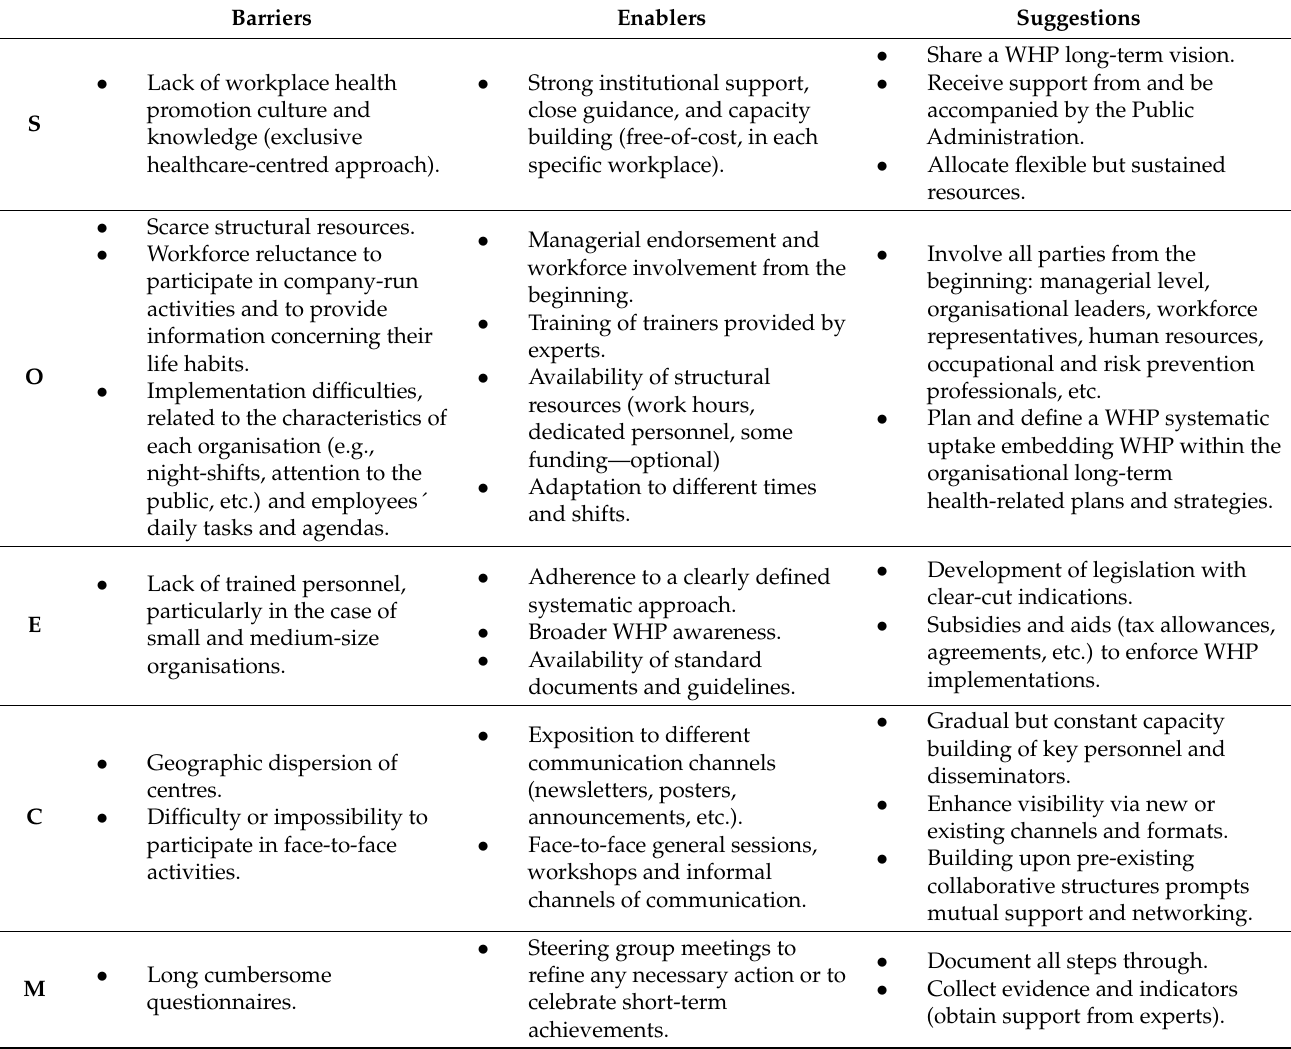
Table 6. Barriers, enablers, and suggestions for future implementations. Barriers